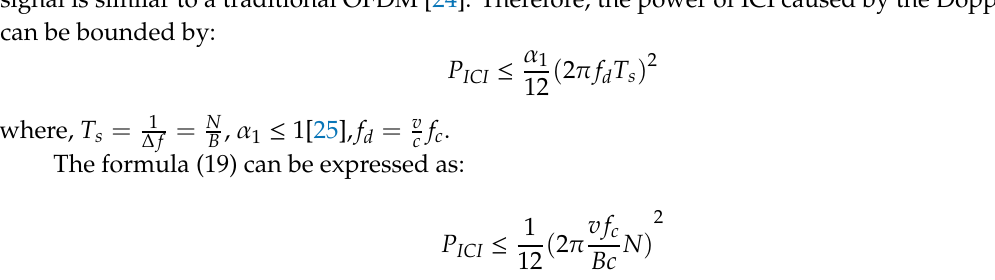
Figure 9. The relationship between the vector length and propagation range.